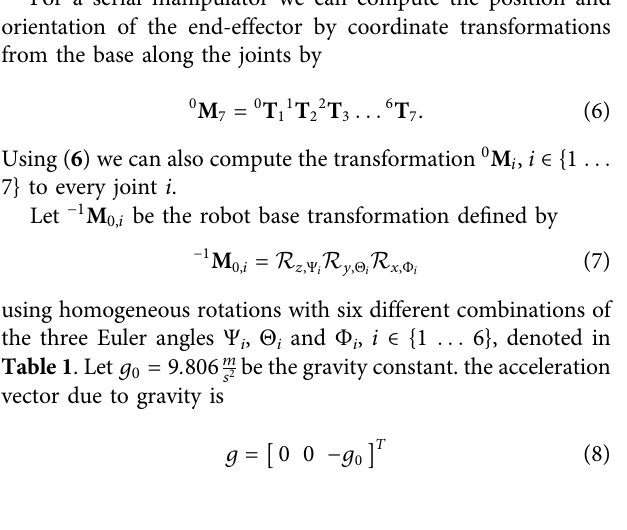
be the gravity constant. the acceleration s 2